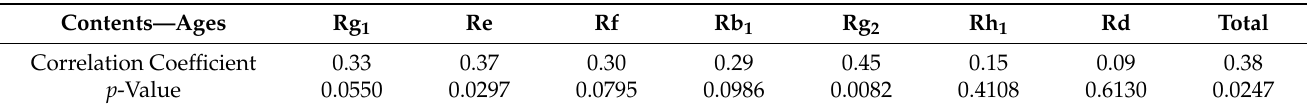
Table 6. Correlations between contents of the seven ginsenosides and the growing ages for ginseng samples with certain growing ages ( n =